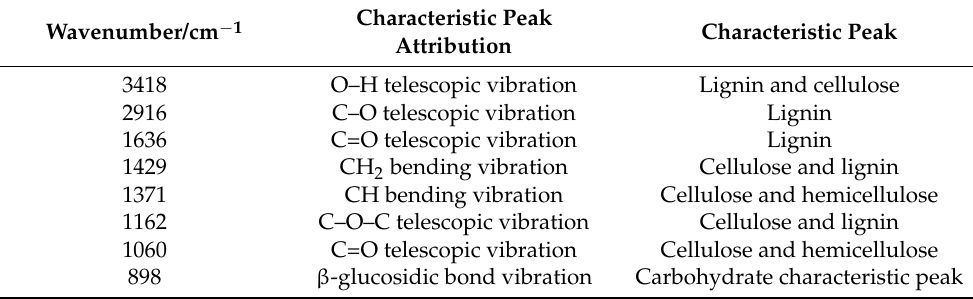
Figure 3. Infrared spectroscopy of waste hemp fiber. Table 2. Infrared spectral analysis results of waste hemp fiber.